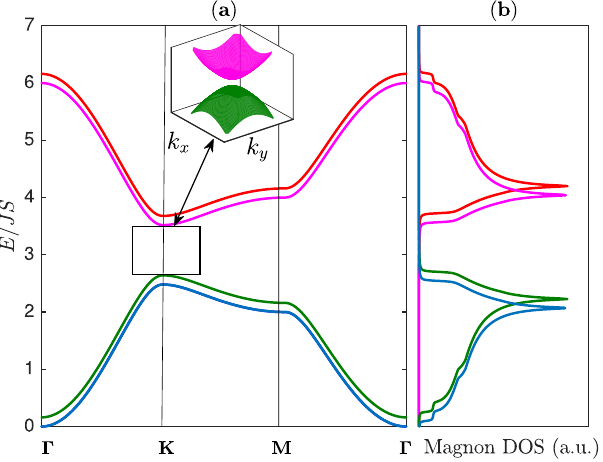
Figure 6. The magnon energy bands and magnon density of states. ( a ) Magnon band structures with gap Dirac magnon-nodal lines (rectangular box) as well as gap Dirac magnon points along the Brillouin zone paths in Fig. 1(b). The inset shows the 3D band near K as indicated by the same colour codes of the 2D bands. ( b ) The corresponding magnon density of states (DOS). The plots are generated by setting Δ DM = 0.1 J , J L = 0.08 J .